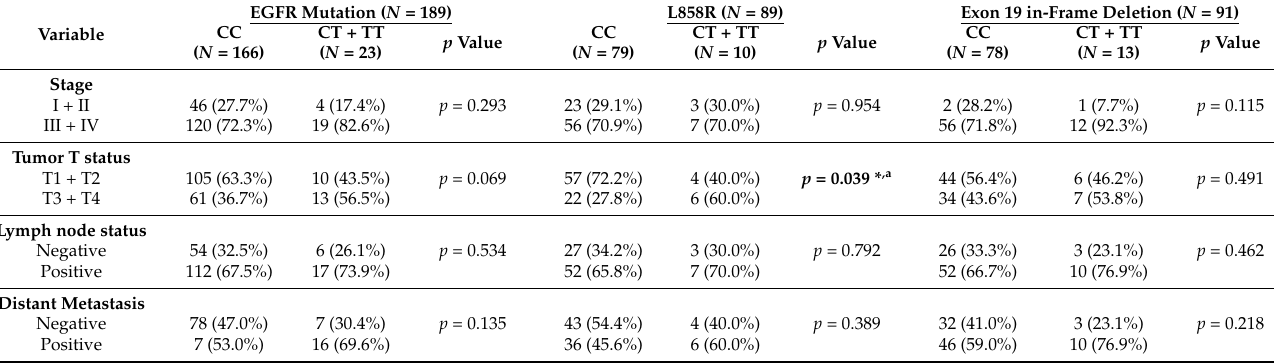
Table 5. Associations between polymorphic genotypes of WWOX (rs73569323) and clinicopathologic characteristics of lung cancer with EGFR